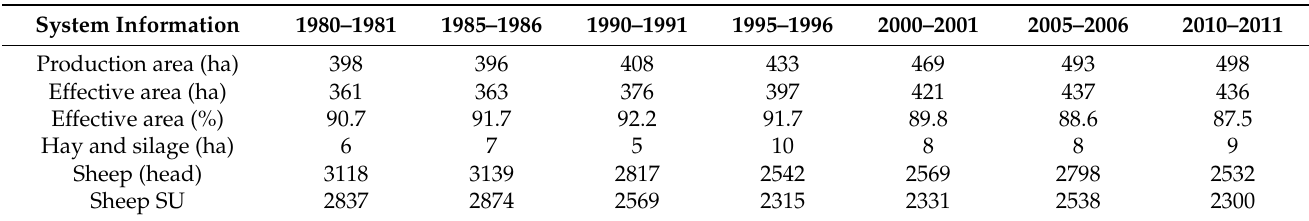
Table 1. Changes in average production area, effective area, sheep, cattle, animal stock units (SU), lambing and calving percentages, and chemical inputs in New Zealand southern North Island sheep and beef cattle systems from 1980 to 2011. All values are expressed on a per production system basis. Data were obtained from various B+LNZ sources as described in the